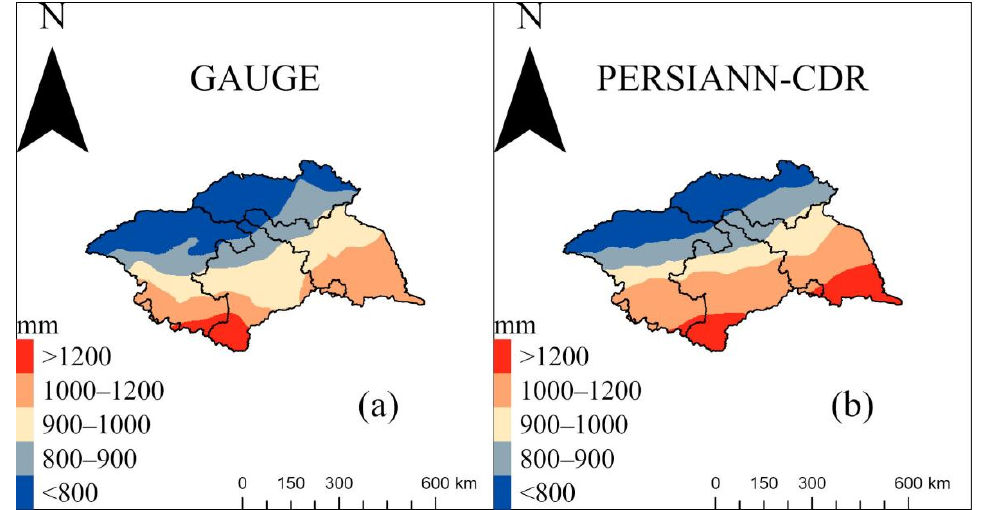
Figure 6. Spatial distribution of annual average precipitation of ( a ) Gauge observation and ( b ) PERSIANN-CDR